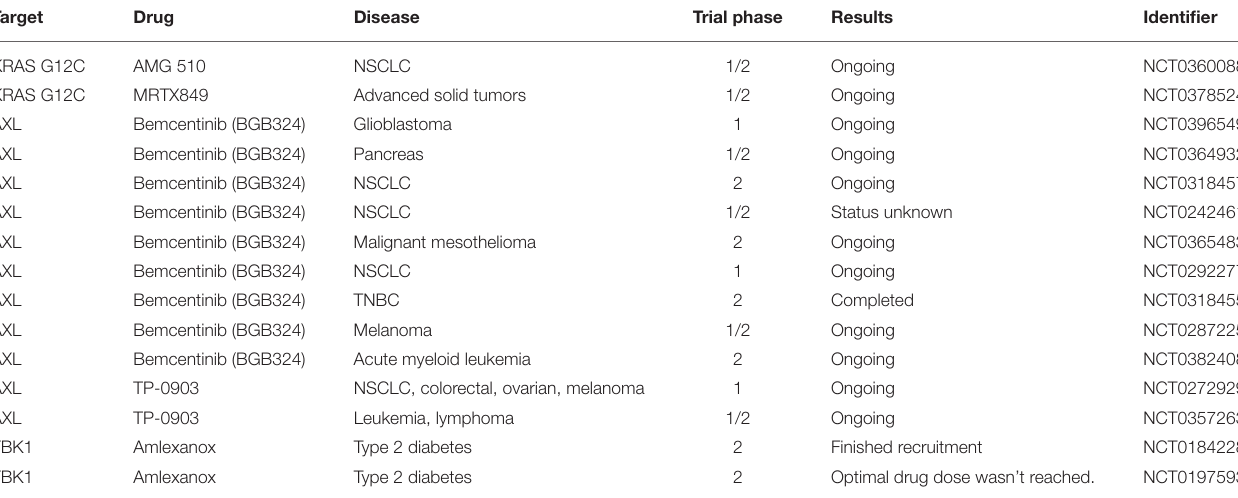
TABLE 1 | Clinical trials targeting KRAS, AXL, and